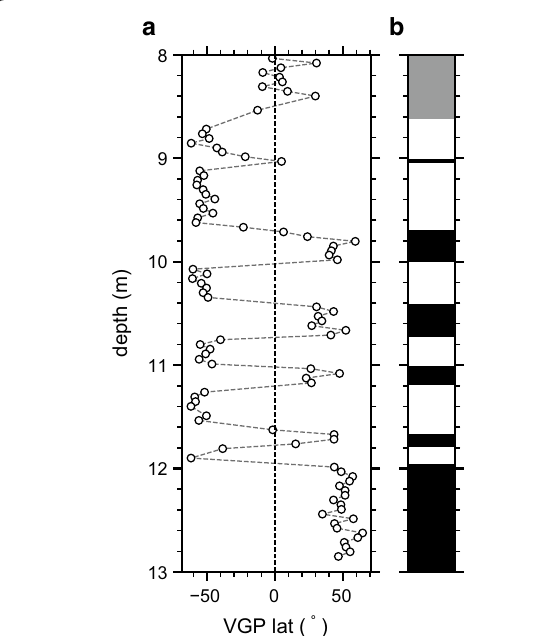
0.8 Fig. 3 Chemical digestion results. a Weight fraction of residue after CBD treatment (open circles) and subsequent acetic acid treatment (crosses). b Weight fraction of residue after sodium pyrosulfate